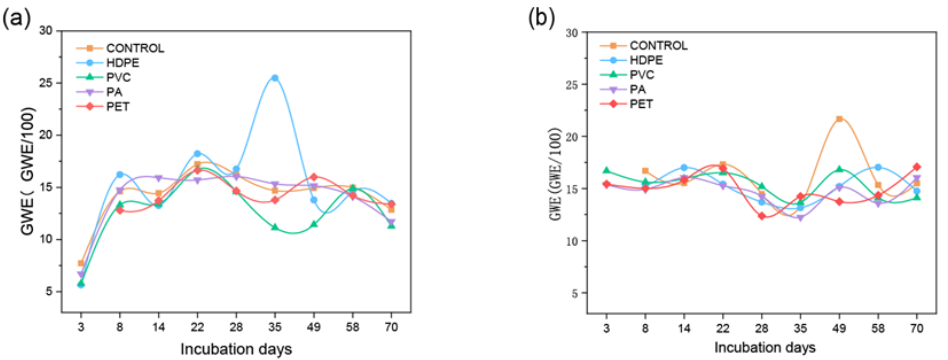
Figure 6. GWE in saltwater ecosystems ( a ) salt marsh ( b ) mangrove forest.